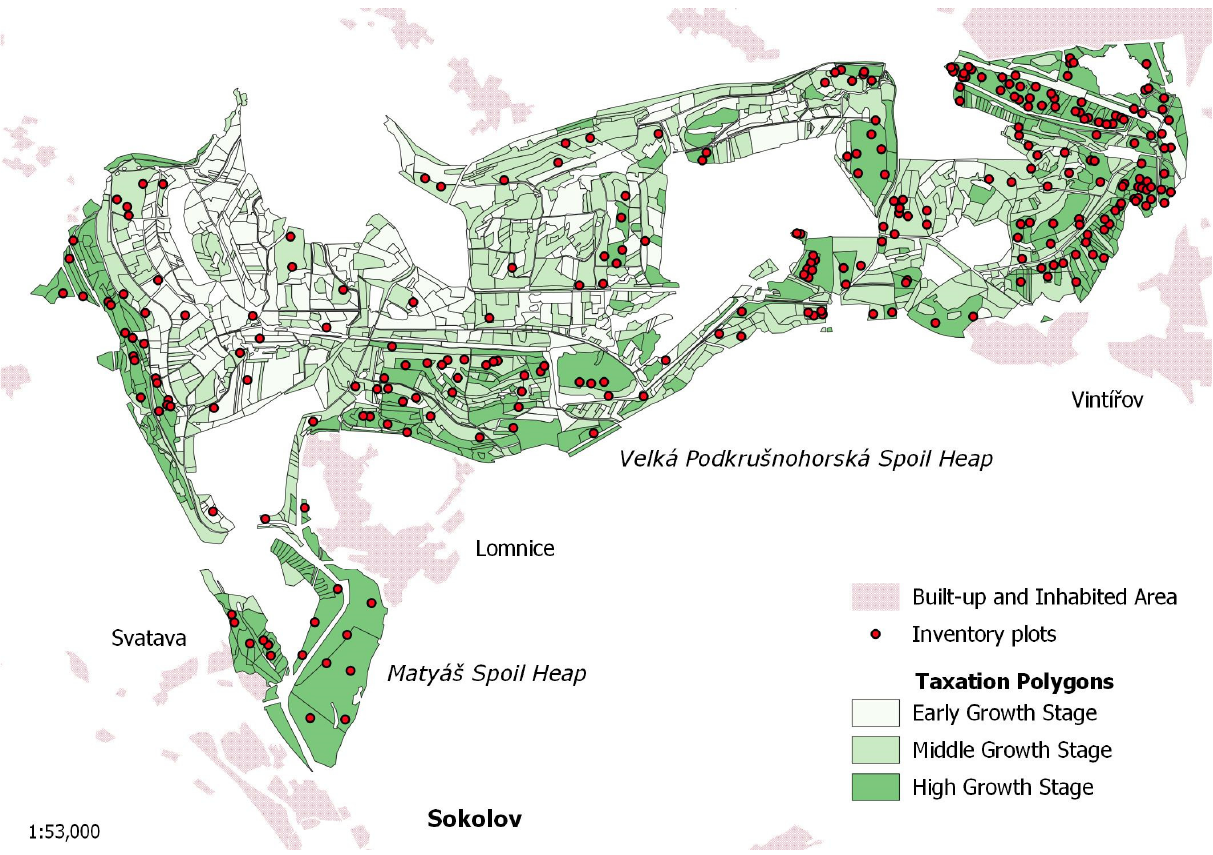
Figure 2. The geographical distribution of inventory plots and taxation polygons with correspond- ing growth stages of restored forest stands on the Velká Podkrušnohorská spoil heap and Matyáš spoil heap. spoil